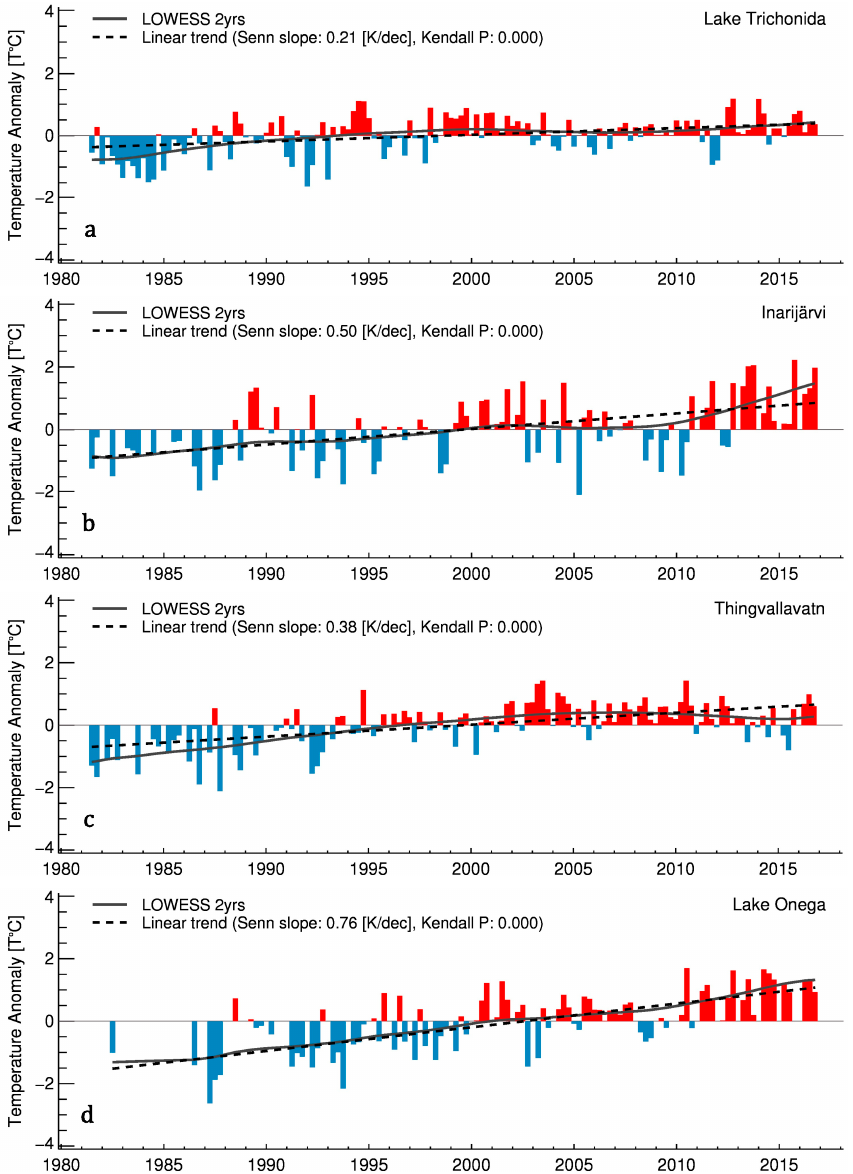
Figure 9. Temperature trends of Lake Trichonidas ( a ), Inarijärvi ( b ), Thingvallavatn ( c ), and Lake Onega ( d ). Blue bars indicate temperatures below the long-term mean, whereas the red bars show warmer years. The dashed line shows the linear trend, whereas the solid black line shows the locally weighted scatterplot smoothing (LOWESS) over a 2-years period. Lake Trichonidas ( a ) is the lake with the lowest latitude (except for Djorf Torba), whereas Inarivjärvi ( b ) is the lake at highest latitude. The same applies for the longitude where it goes from Thingvallavatn ( c ) in the west to Lake Onega ( d ) in the east.